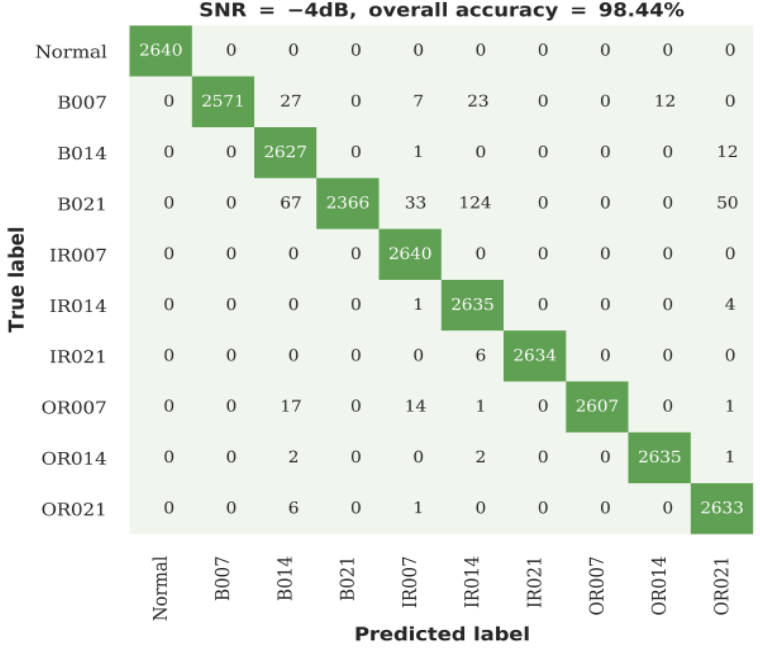
Figure 36. ROC curves for ( a ) RF and ( b ) XG-Boost for bearing fault classification [97].